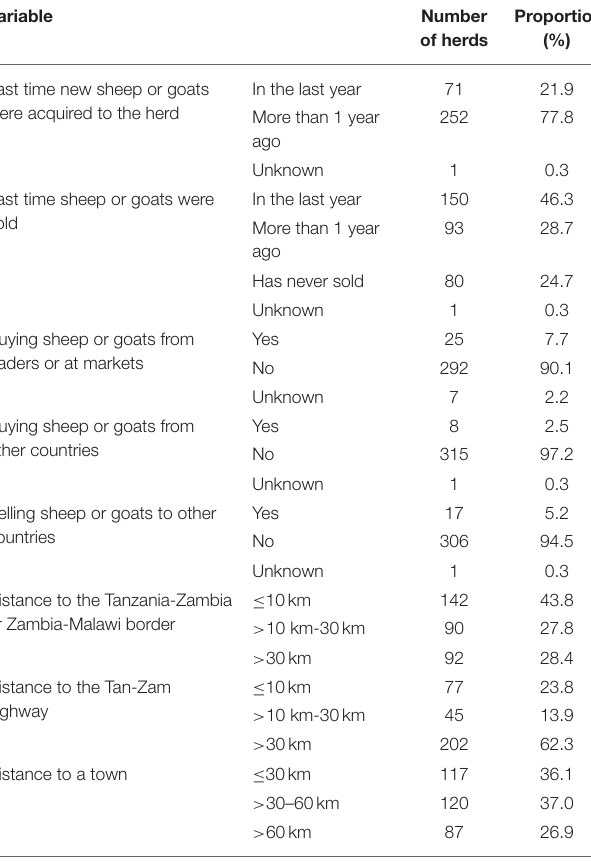
TABLE 1 | Distribution of samples collected from sheep and goats in Zambia and Tanzania in September to October 2018. Variable Number